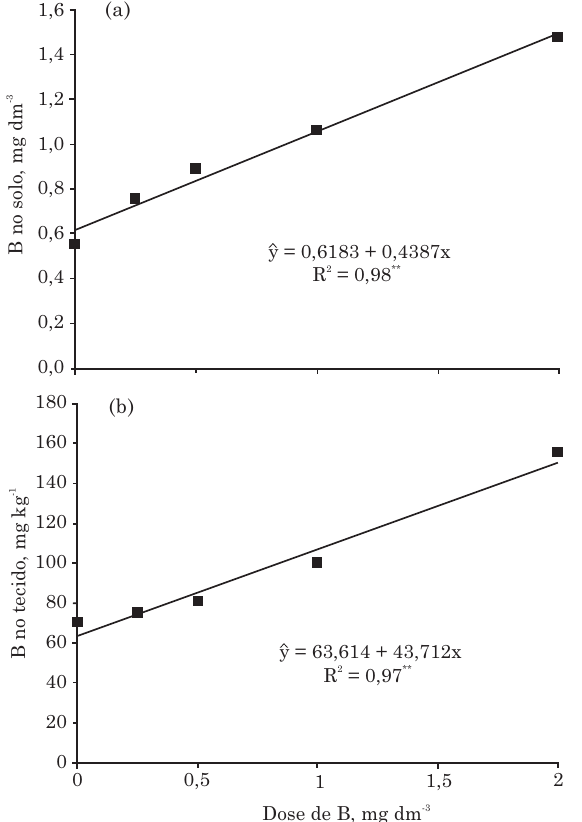
no desenvolvimento do sistema radicular e não influenciou o desenvolvimento da parte aérea.